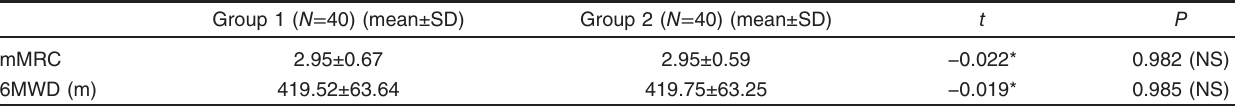
Table 2 Comparison between group 1 and group 2 regarding pretreatment modified-Medical Research Council and 6min walk distance